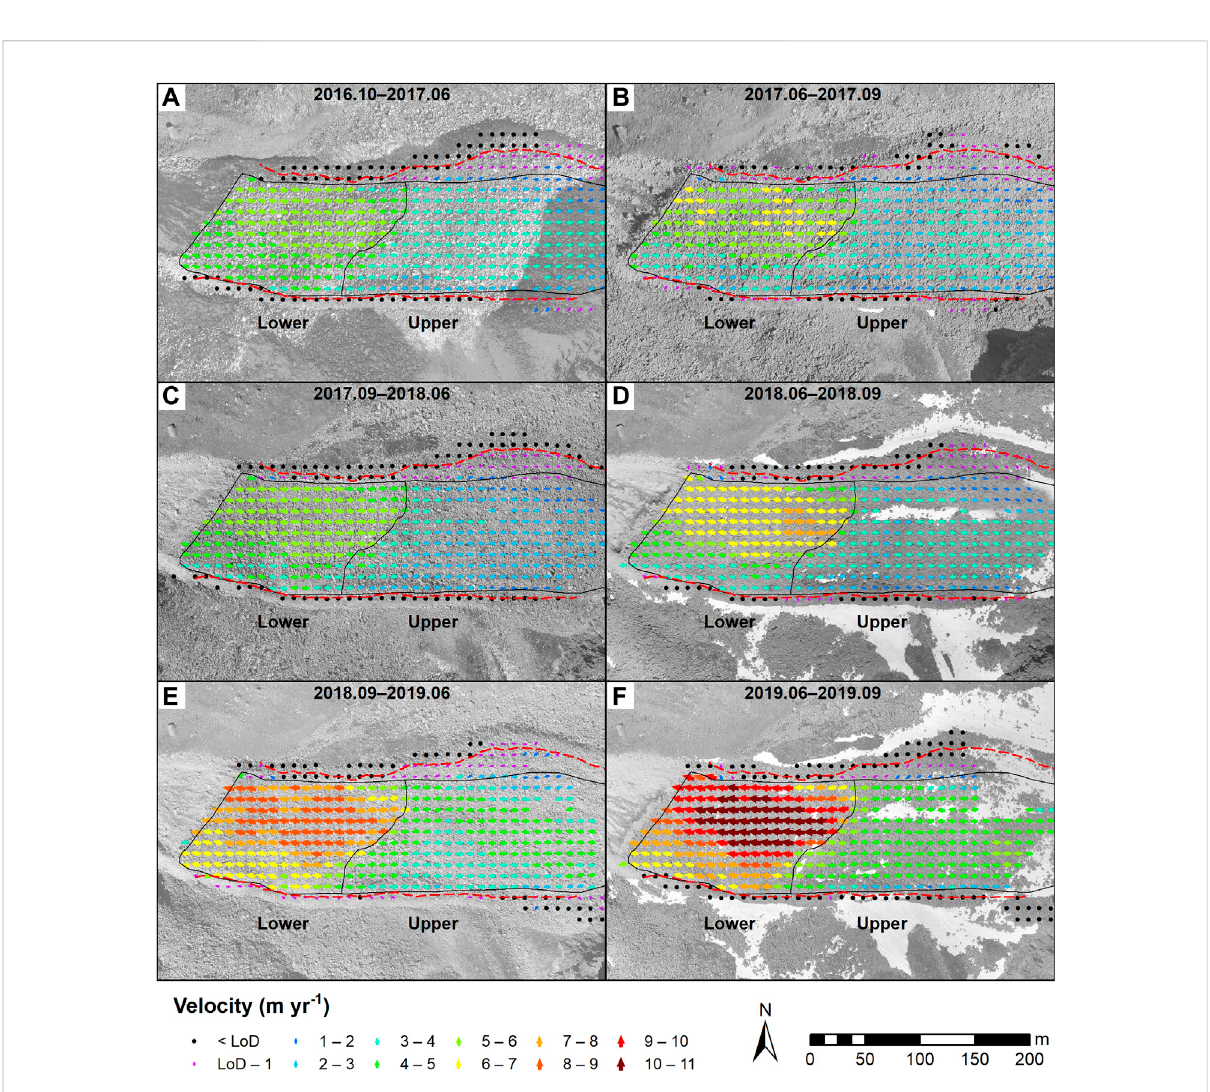
FIGURE 4 Maps of the horizontal surface velocities between 2016 and 2019. Background images correspond to the fi rst orthomosaic used during each period of image matching. Black polygons correspond to the lower and upper sections, and red dashed lines correspond to the lateral levees.